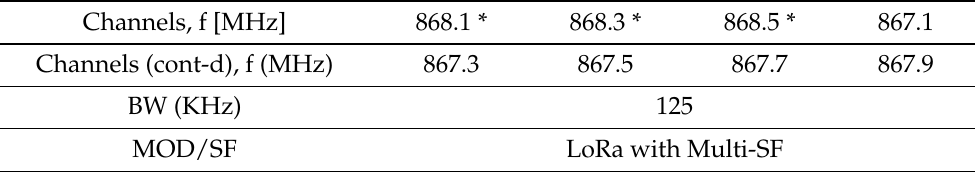
MOD/SF LoRa with